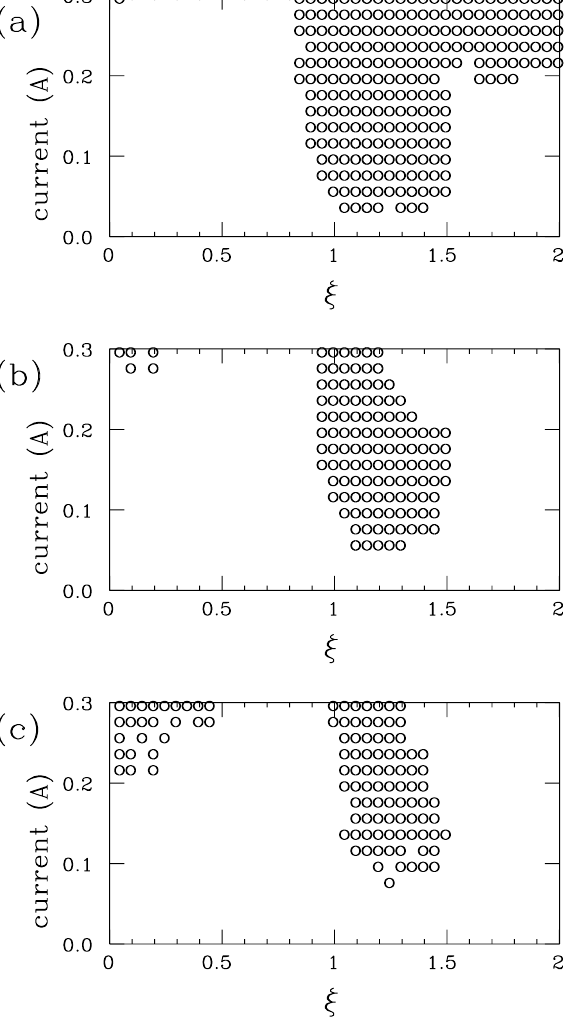
FIG. 13. Instabilities observed in 500 000 turn simulations of active Landau-cavity operation with the LF20 lattice for three values of the active Landau-cavity effective rf coupling (cid:3) b 2 (cid:4) . (a) b 2 (cid:1) 40 , (b) b 2 (cid:1) 80 , and (c) b 2 (cid:1) 160 .